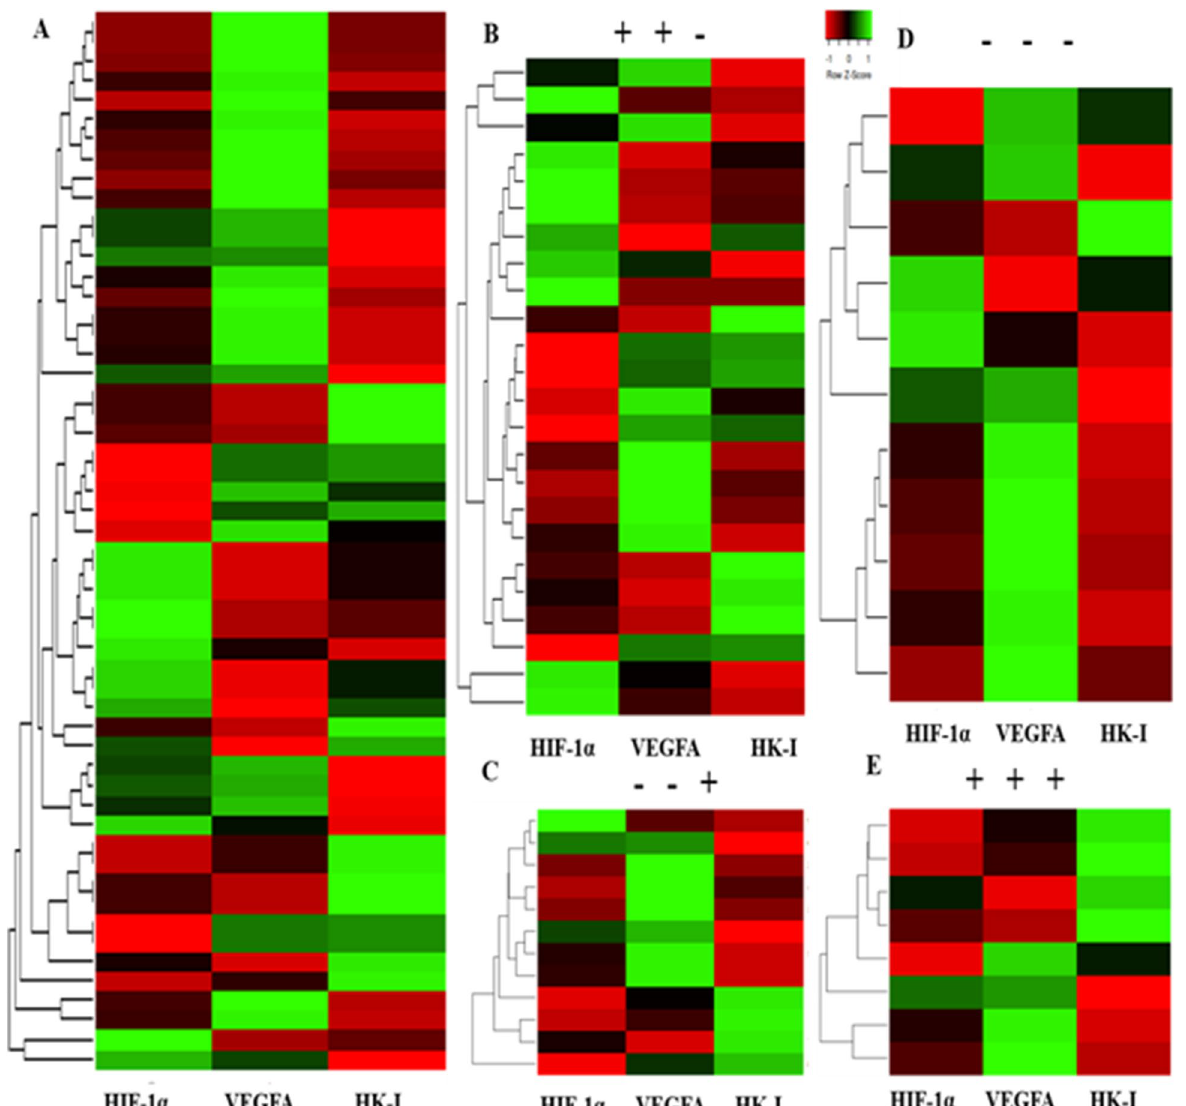
Fig. 8 Heat map plot of HIF-1α, VEGFA and HK-I as in ( A ) along with the classification based on the ER, PR and Her2 status as in ( B - E ). Columns of the plot represent the genes and the rows represent samples. TNBC. - - represents Estrogen, Progesterone negative & Her2 positive. +